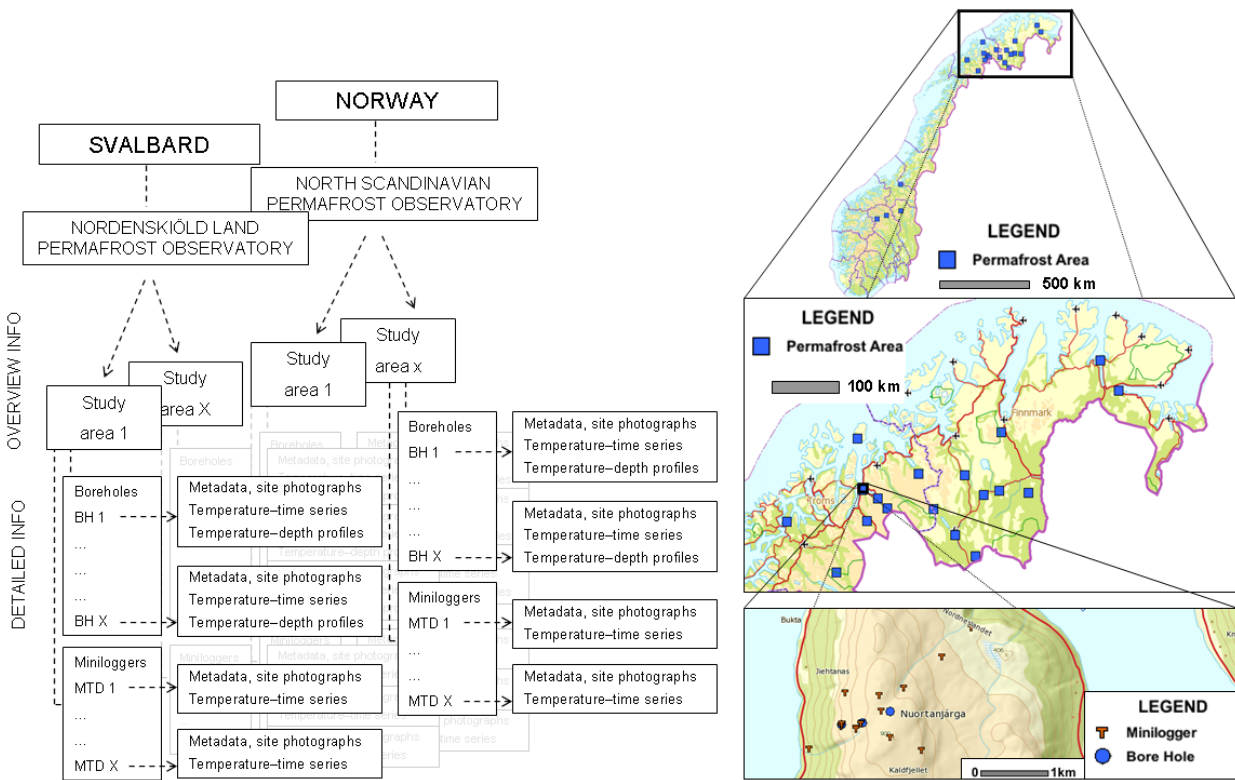
Figure 7. Overview of the structure of NORPERM. The database is structured into four levels with decreasing spatial scale, represented by the entire land areas of Svalbard and Norway at the coarsest scale, the two permafrost observatories at the regional scale followed by the study areas and finally the measurement sites at the finest level of detail. The insert maps shows how this is displayed in the map, with to the upper right the entire Norwegian land area with study areas shown as point symbols, in the middle right the North Scandinavian Permafrost Observatory with permafrost areas also here shown as point symbols, and to the lower right the Nordnes study area with the measurement sites shown as point